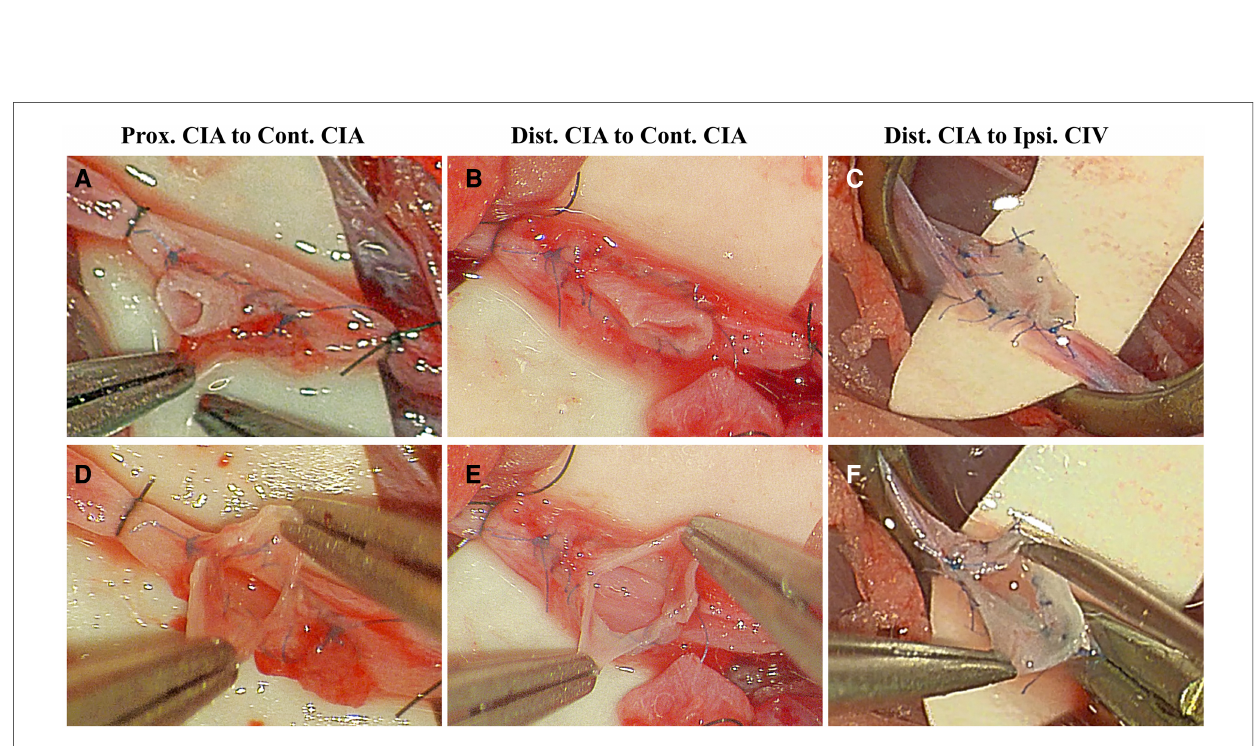
FIGURE 7 Distribution of stitches, ori fi ce size, and intimal attachment were inspected in end-to-side anastomosis using rat common iliac arteries. Good distribution of stitches, wide ori fi ce and intimal attachment were recorded in Prox. CIA-Cont. CIA ( A,C ), Dist. CIA-Cont. CIA ( B,D ), and Dist. CIA-Ipsi. CIV ( C,F ) end-to- side anastomosis. CIA, common iliac artery; CIV, common iliac vein; Cont., contralateral; Dist., distal; Ipsi., Ipsilateral; Prox.,